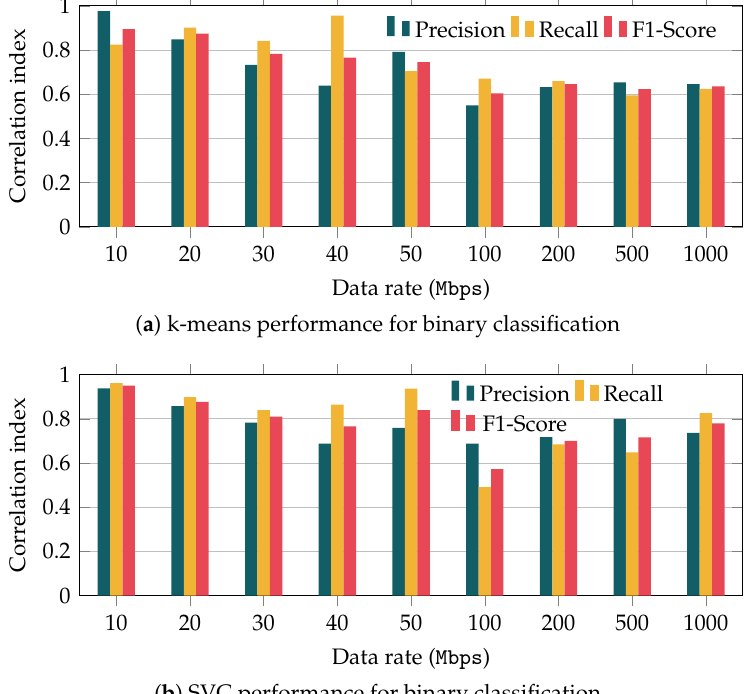
Figure 9. Performance of binary classification for a distance of 40 m and the different data